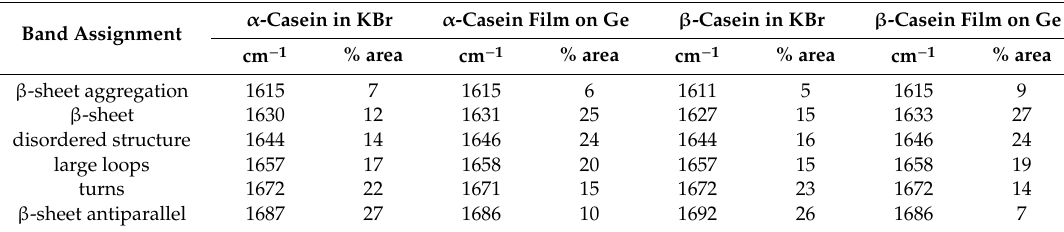
Table 3. Decomposition of amide I vibration band spectra of casein, measured in KBr pellets and in dry film at Ge crystal, into structural